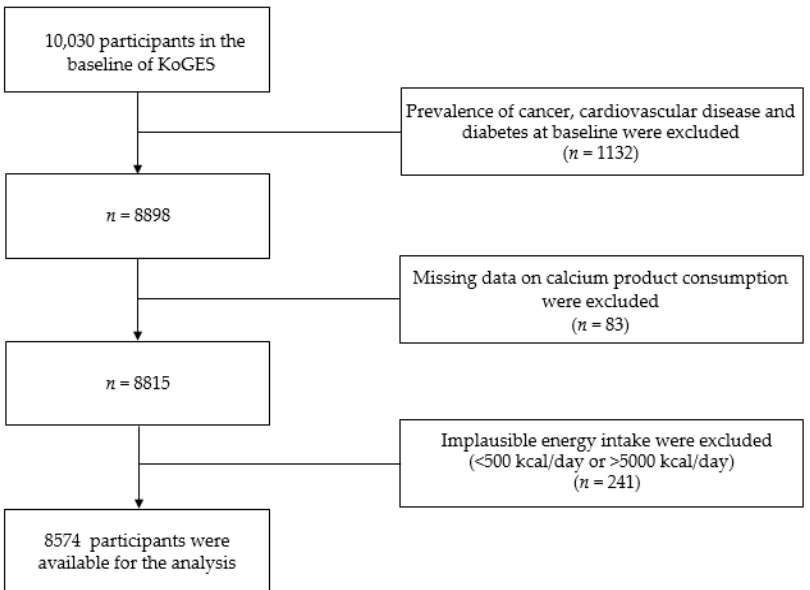
Figure 1. Flow chart showing the participant selection process. KoGES, Korean Genome and Epidemiology study.